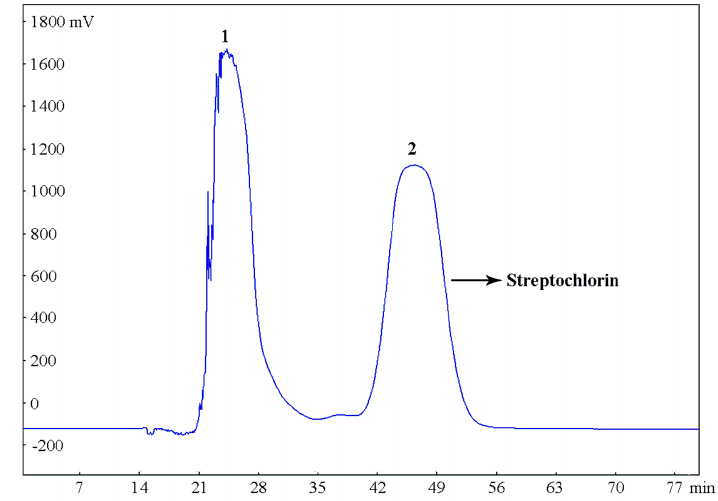
Figure 5. HSCCC chromatogram of the crude extract of Streptomyces strain SYYLWHS-1-4 in the solvent system of petroleum ether–ethyl acetate–methanol–water (9:0.8:5:5, v / v / v / v ), stationary phase: upper phase, mobile phase: lower phase, flow rate: 5.0 mL/min, rotary speed: 800 rpm, column temperature: 25 °C, sample size: 300 mg crude extract dissolved in a 20 mL mixture of upper and lower phases (1:1, v / v ) of solvent system, detection wavelength at 220 nm.